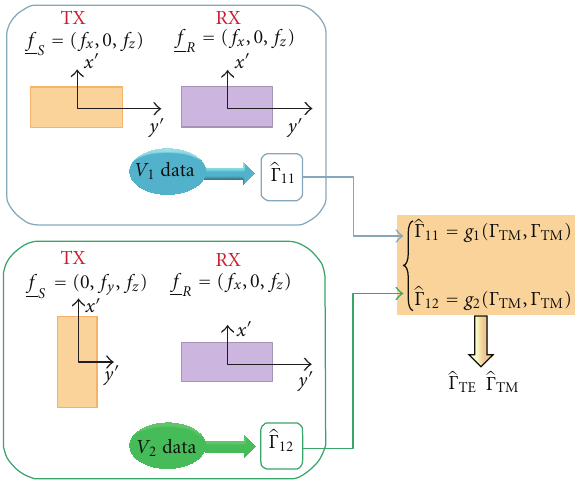
Figure 3: Illustrating the overall estimation procedure.